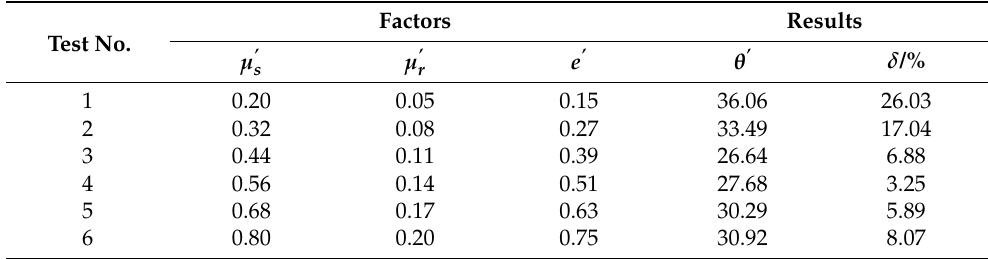
Table 4. Results of the steepest ascent test.